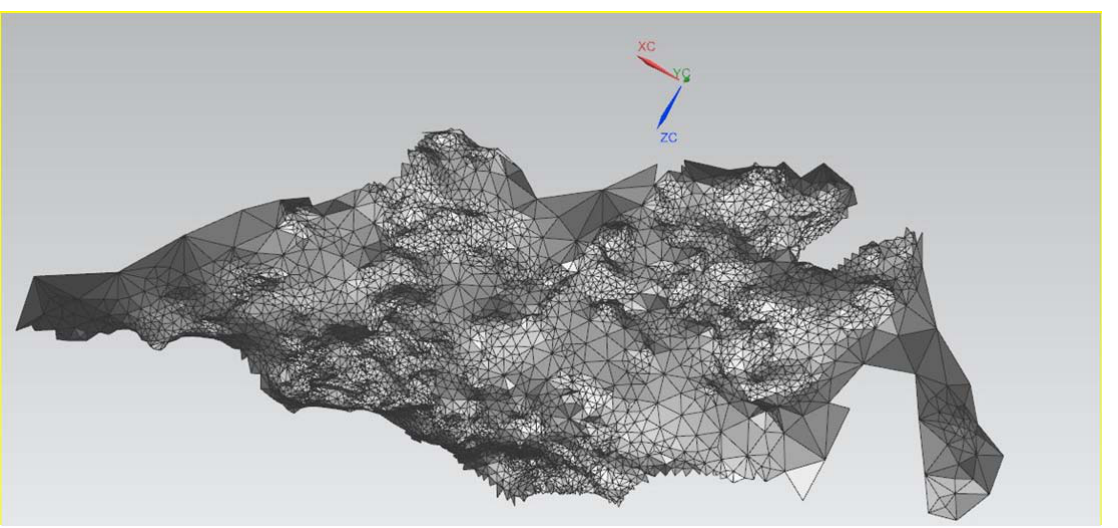
Figure 13. 3D model of confluence of two flows